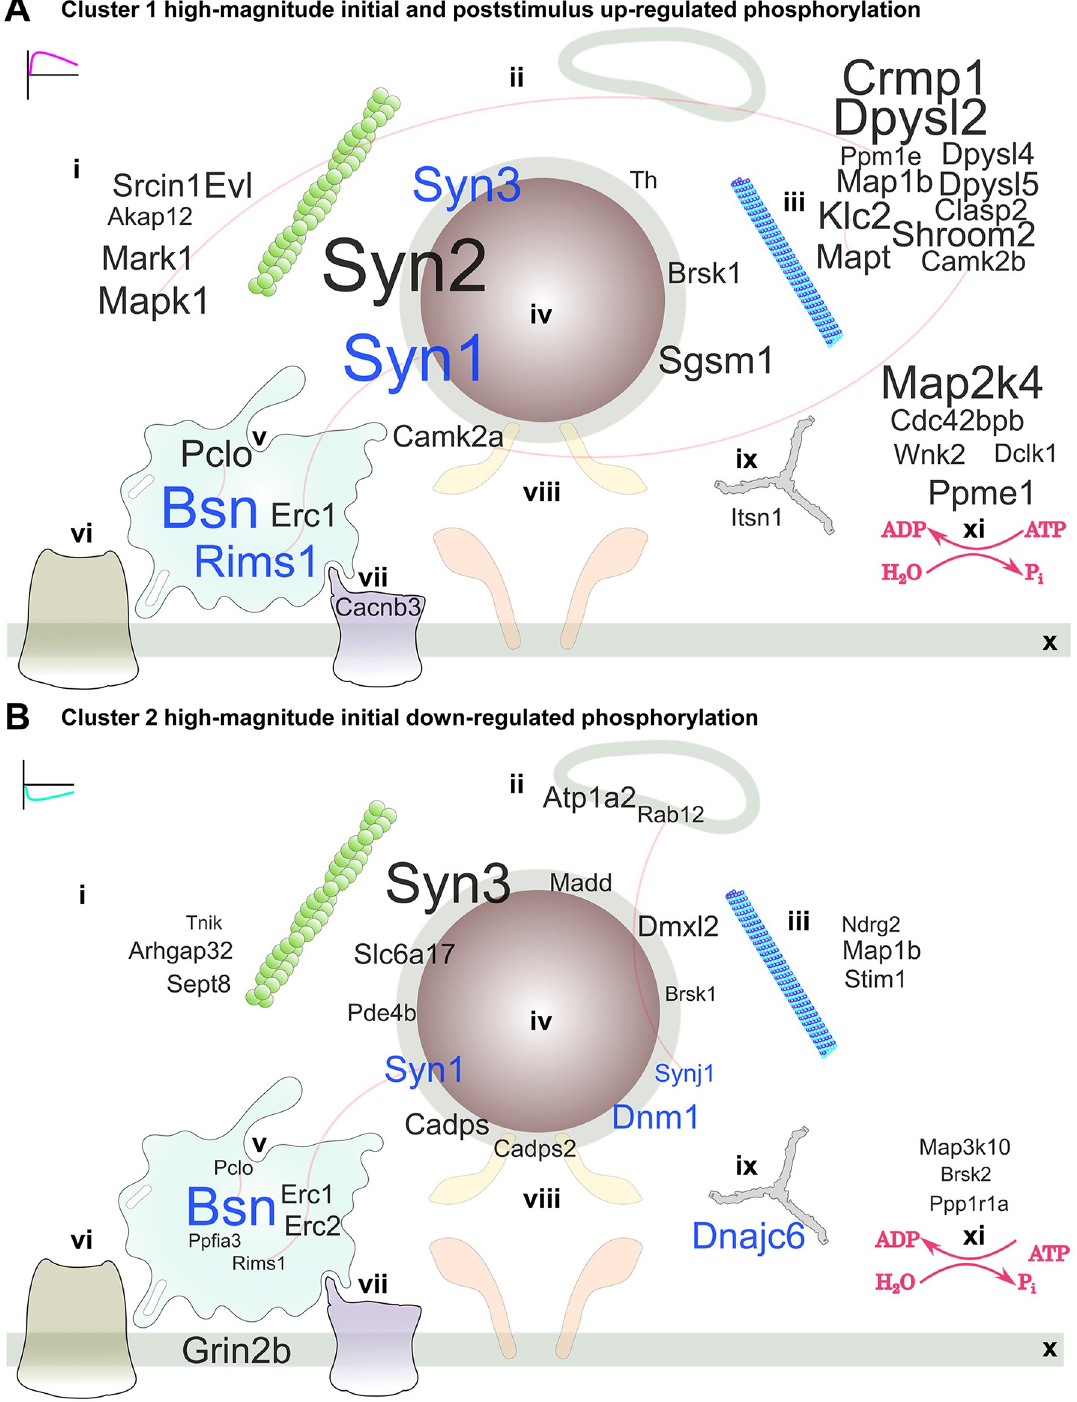
Fig 7. Cluster 1 high-magnitude up-regulated phosphorylation and cluster 2 high-magnitude down-regulated phosphorylation substrates within a network of presynaptic proteins. A word cloud visualization of the synaptosome phosphoproteomics data using gene names anchored to cellular component ontology (subcellular localization). The size of the gene name is scaled to the absolute value of the largest change in the log 2 intensities at any time point or level of stimulation for (A) cluster 1 and (B) cluster 2 phosphopeptides. Localizations: (i) cytoskeleton and actin cytoskeleton, (ii) endosome, (iii) microtubule and microtubule organizing centre, (iv) synaptic vesicle, (v) active zone scaffold, (vi) voltage-gated potassium channel, (vii) voltage-gated calcium channel, (viii) SNARE complex, (ix)